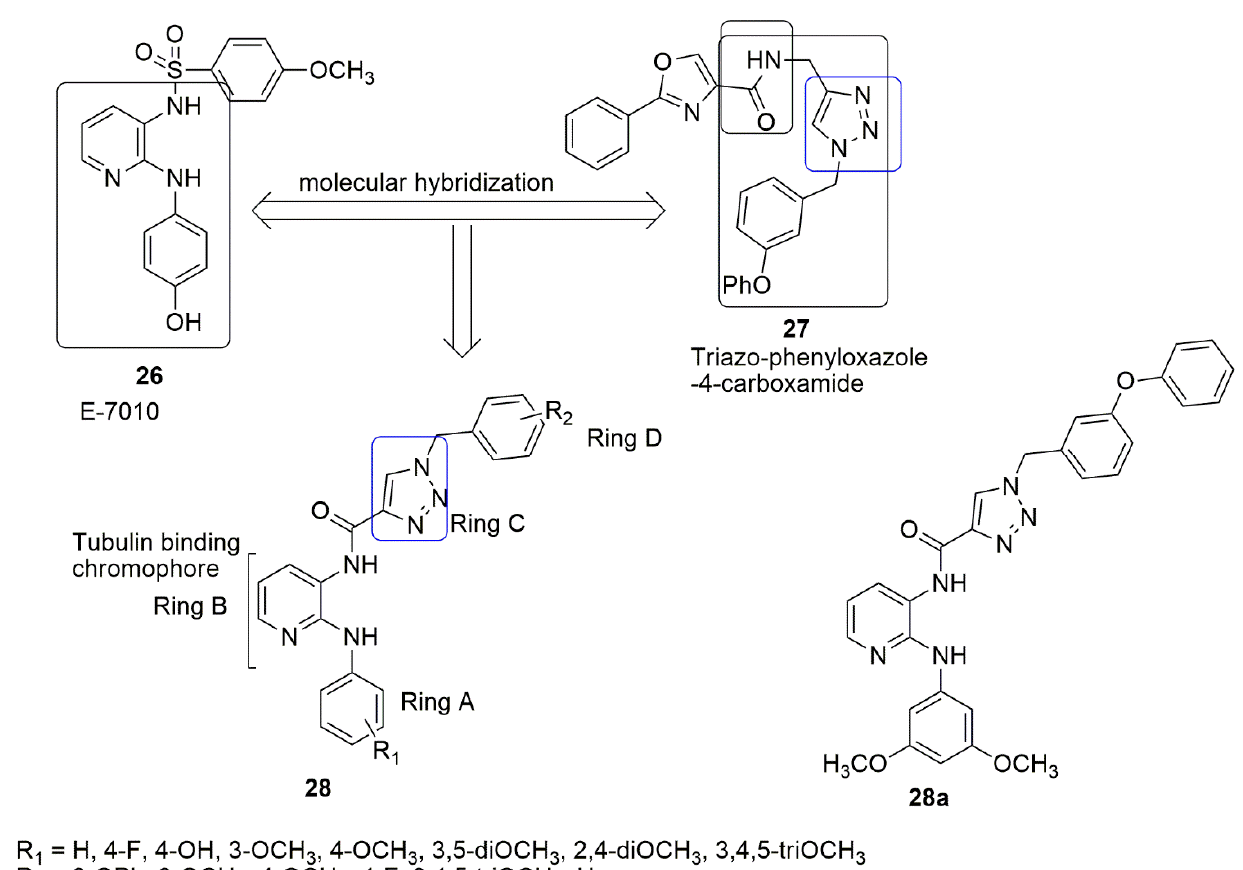
Figure 11. Chemical structures of pyridine-triazole carboxamide evaluated for cytotoxicity and tubulin polymerization.